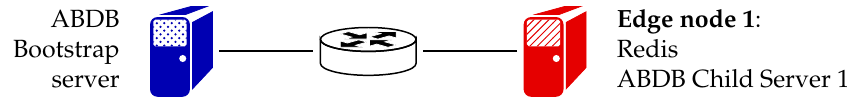
Figure 4. Experimental edge and network setup for evaluating single (child) node performance.